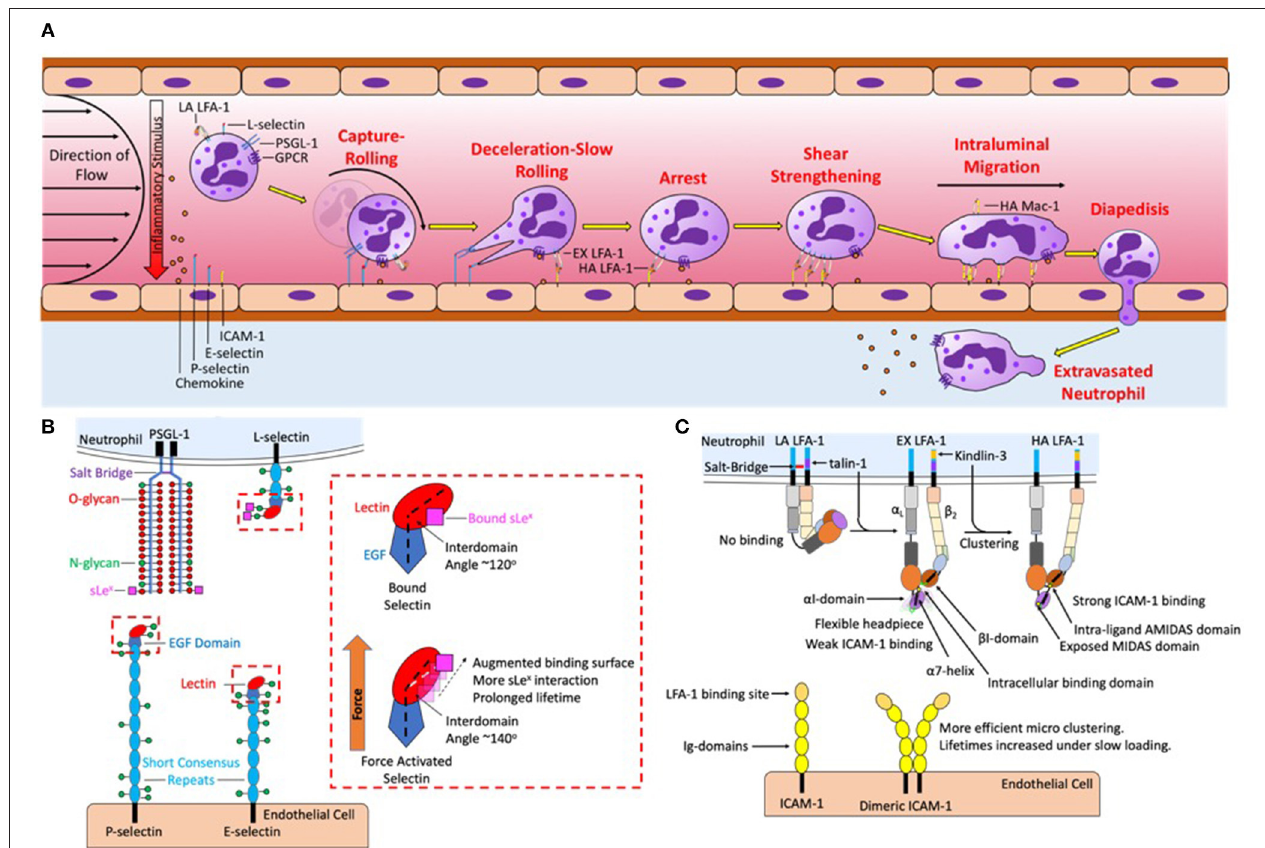
FIGURE 1 | Neutrophil recruitment under shear flow is coordinated by selectins, chemokines, and integrin ligand binding and signaling. (A) The sequential steps of neutrophil recruitment under shear flow is initiated by hydrodynamic forces that bring L-selectin and PSGL-1 on the neutrophil surface in contact with P-selectin and E-selectin on the endothelial plasma membrane, mediating capture, and rolling. To resist shear flow selectins and PSGL-1 form transient yet strong bonds that form at the leading-edge to initiate cell rolling and break at the trailing edge under tensile force. Chemokine captured via glycosaminoglycans on the endothelial surface and force acting on L-selectin then activates LFA-1 into an extended conformation to initiate deceleration and slow rolling. A second signal is initiated by L-selectin and CXCR that upshifts integrin into a high affinity state thereby initiating arrest. Initially integrin LFA-1 is spread randomly throughout the surface of the neutrophil, force acting on high affinity LFA-1 initiates their redistribution that reinforces shear resistant cell arrest. Clusters of LFA-1 transduce calcium signaling and neutrophil shape change, leading to high affinity Mac-1 mediated intraluminal crawling along a gradient of chemokine on the endothelial surface, directing the neutrophil to the desired site of migration. Endothelial diapedesis promotes neutrophil access the site of injury or tissue infarct. (B) Mechanics of PSGL-1 and L-selectin bond formation play a key role in force transduced signaling. PSGL-1 is primarily decorated with O-glycans while L-selectin is primarily decorated with N-glycans, sLe x deposited on these glycans binds to the lectin domain of P-selectin and E-selectin. Under tensile bond force catch-bonds are formed by a change in intracellular angle of selectin EGF-Lectin domain in all three selectins. Selectin catch-bonds are necessary to mechanosignal activation of LFA-1 under shear conditions in the absence of chemokine. The red box details one potential mechanism in which the selectin interdomain angle between the lectin and EGF domain shifts in response to force allowing for prolonged bond lifetimes. (C) LFA-1 is expressed predominantly on membrane microvilli in a low affinity conformation, stabilized by a salt-bridge that clasps together the intracellular α L and β 2 tails. Signaling through selectin and chemokine initiates talin-1 recruitment to the proximal NPxF motif on the β 2 -integrin that breaks the salt-bridge and extends the integrin, revealing the ICAM-1 binding site in the headpiece. However, the headpiece remains flexible and the MIDAS binding domain remains obscured, supporting weak ICAM-1 bonds. Kindlin-3 binding to the distal NPxF motif promotes transition to a high affinity state and stabilizes microclustering of talin-1 and ICAM-1 bound LFA-1 monomers. Tensile bond force acting on high affinity LFA-1 is transduced intracellularly through a shift in the α 7 helix of the α I domain. This in turn induces an allosteric shift that exposes the MIDAS domain allowing for recognition of ICAM-1 and stable bond formation. The binding between ICAM-1 and high affinity LFA-1 at low force regimes is amplified by tandem bond formation with dimeric ICAM-1.